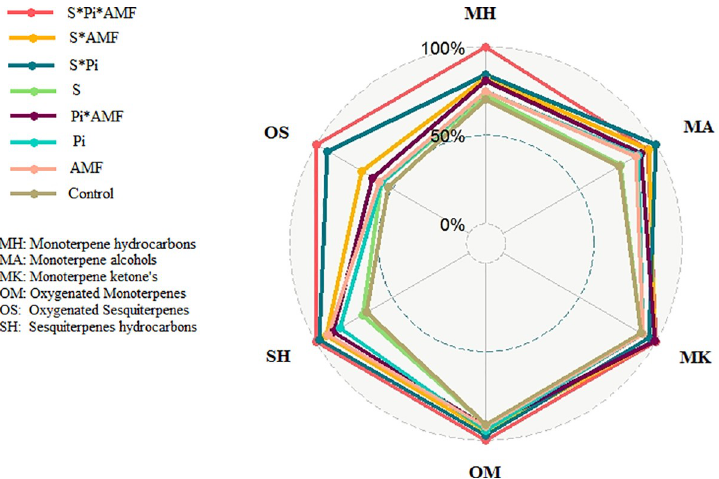
Fig 10. Changes in terpenoid content in inoculated and non-inoculated peppermint with ( P . indica , AMF and co- inoculation) under salinity stress in peppermint plant. S–Salinity; P . indica ; AMF–Mycorrhizae treatment; AMF � P. indica–Mycorrhizae and P . indica treatment.